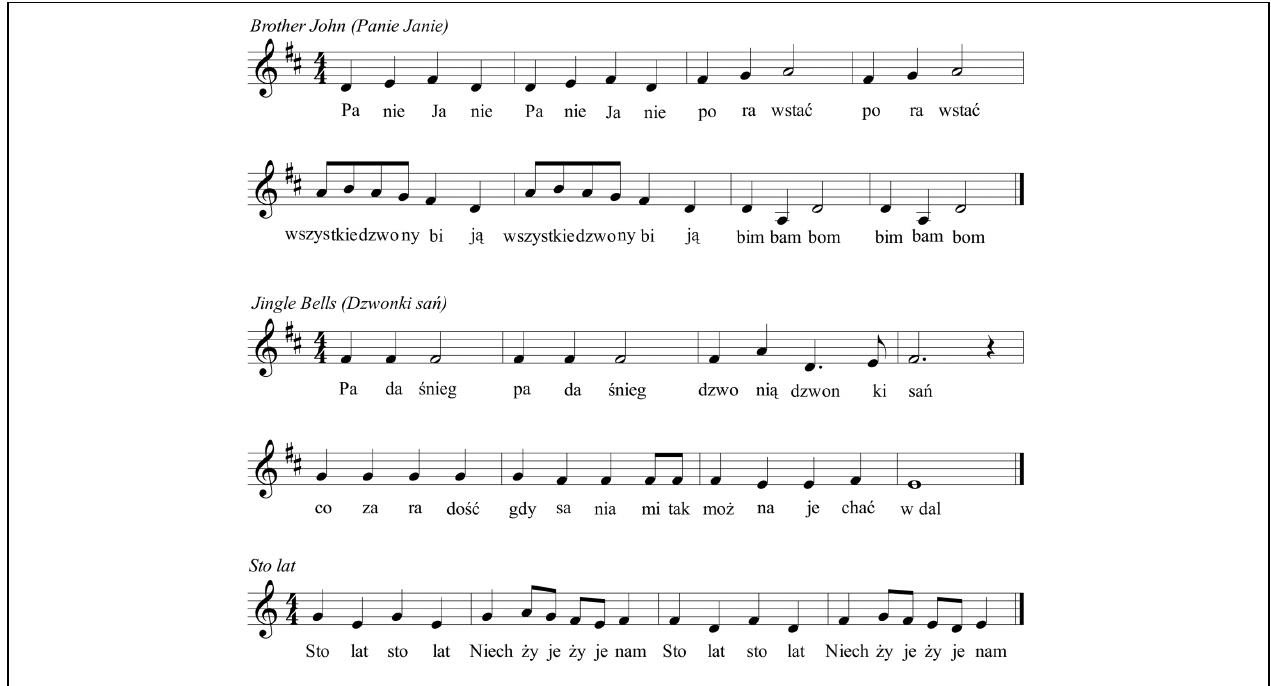
FIGURE 2 | Score of familiar melodies used in Tasks 4 and 5 of the